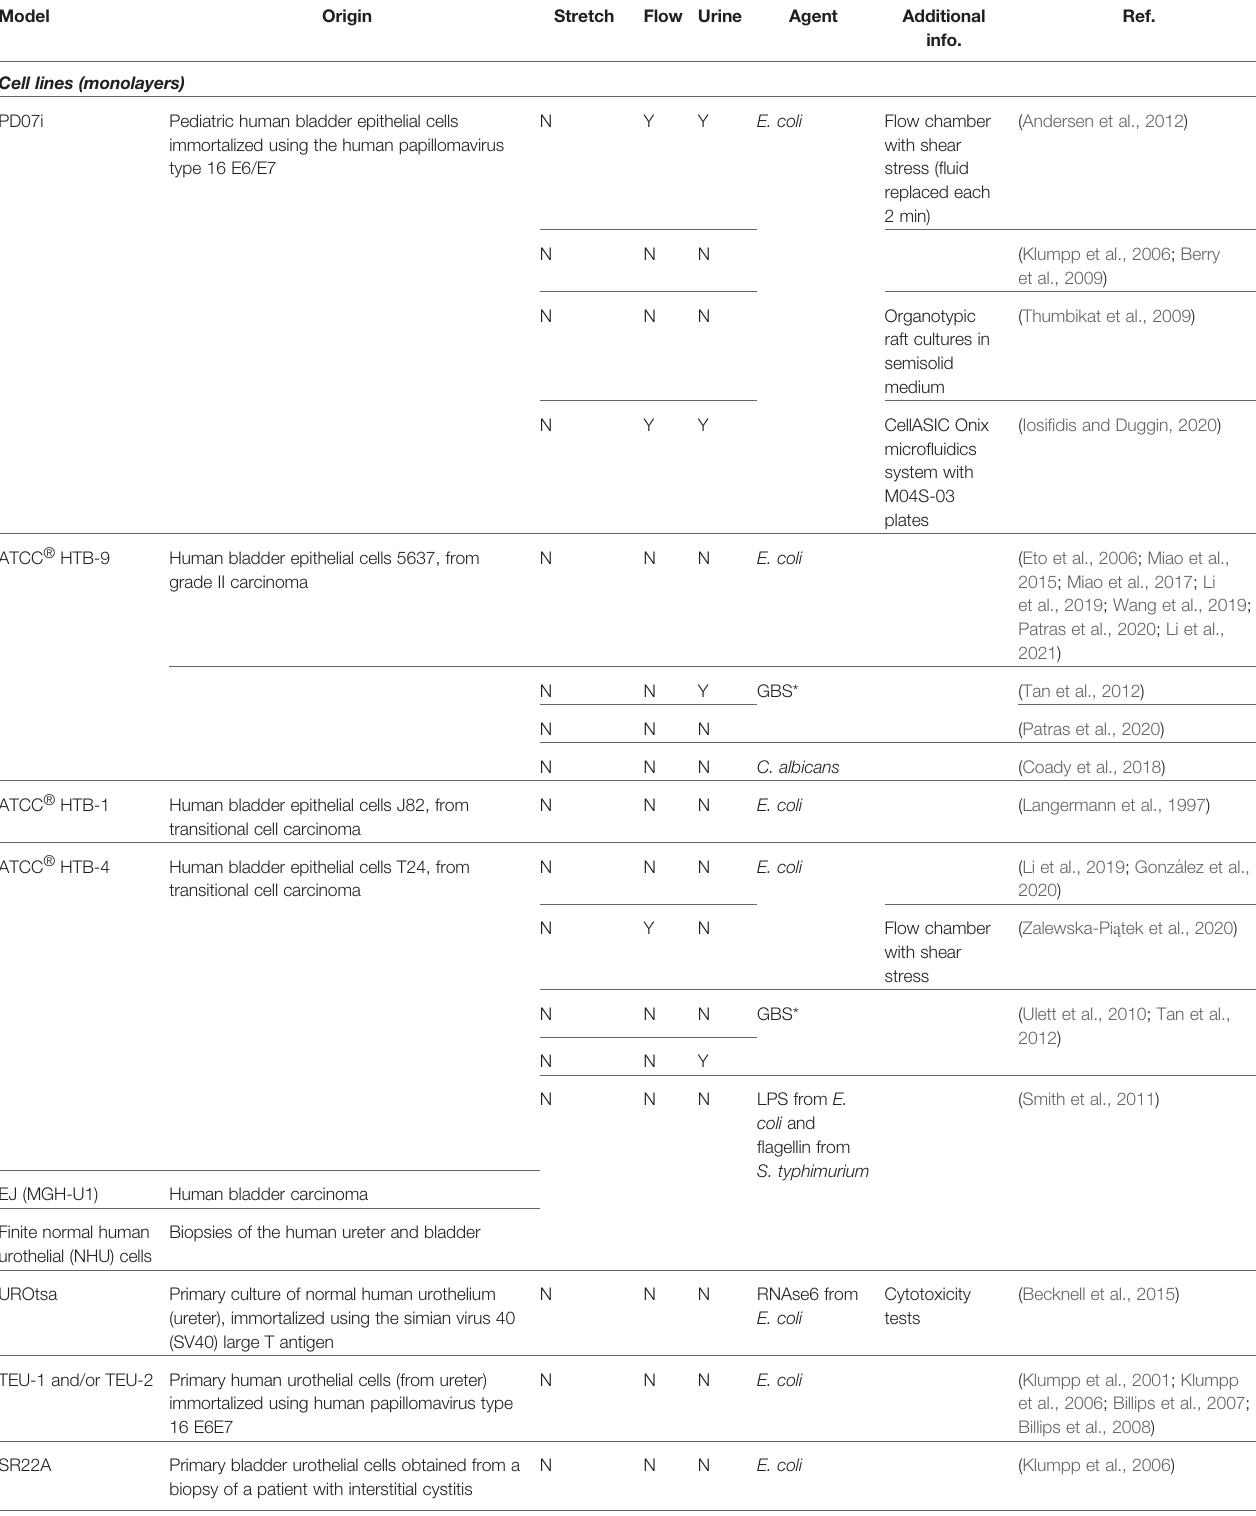
TABLE 2 | In vitro human bladder cell-based models used for UTI